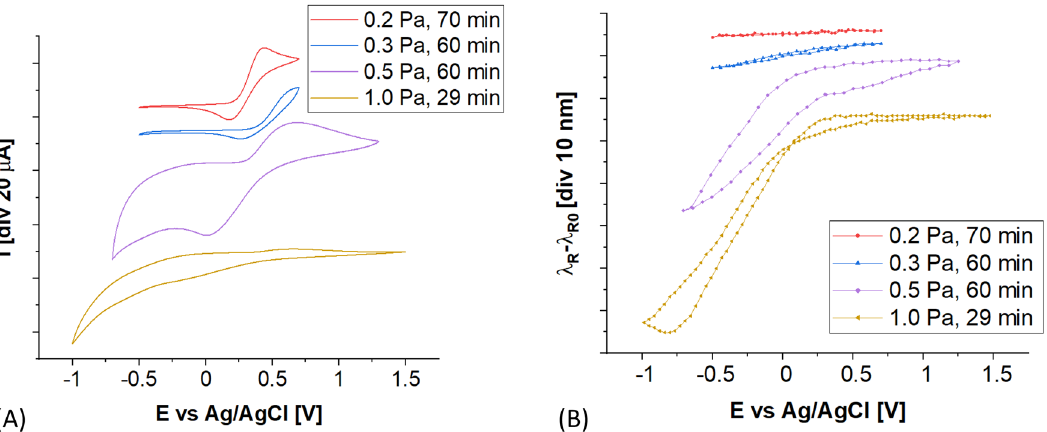
Figure 6: (A) EC and (B) optical responses received for ITO-LMR used as a working electrode, when various ITO deposition p are considered. The analysis was performed in 0.1 M PBS and 1mM 1,1 ′ -ferrocenedimethanol as a redox probe. Scan rate was set to